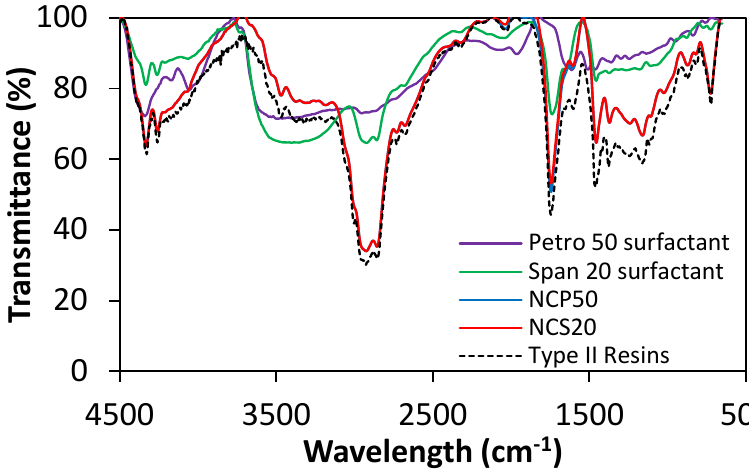
Figure 4. FTIR spectra of vacuum residue-isolated type II resins, Span 20 surfactant, Petro 50 surfactant, and the synthesized NCS20 and NCP50 materials.